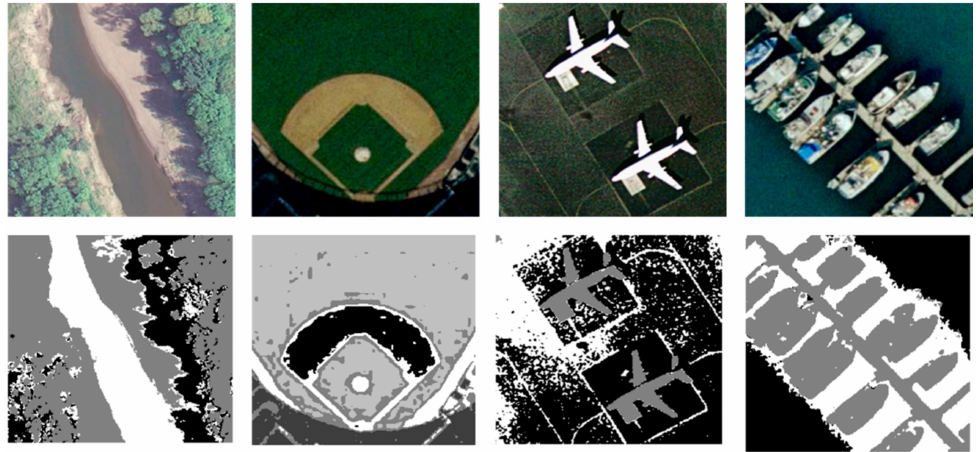
Figure 2. Fuzzy C-means segmentation over some images from UCM Dataset: (row 1) the original images; (row 2) the segmented